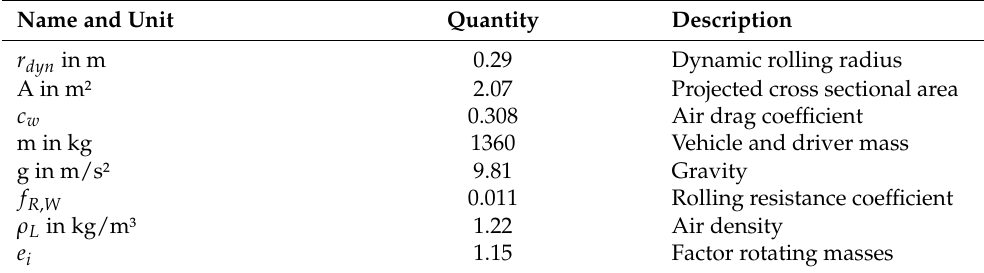
Table 1. Parameters for calculating the driving resistances of the VW